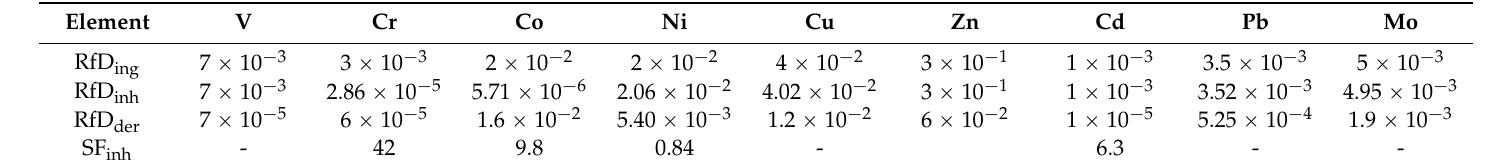
Table 3. References dose (RfD) for non-carcinogenic metals and slope factors for carcinogenic